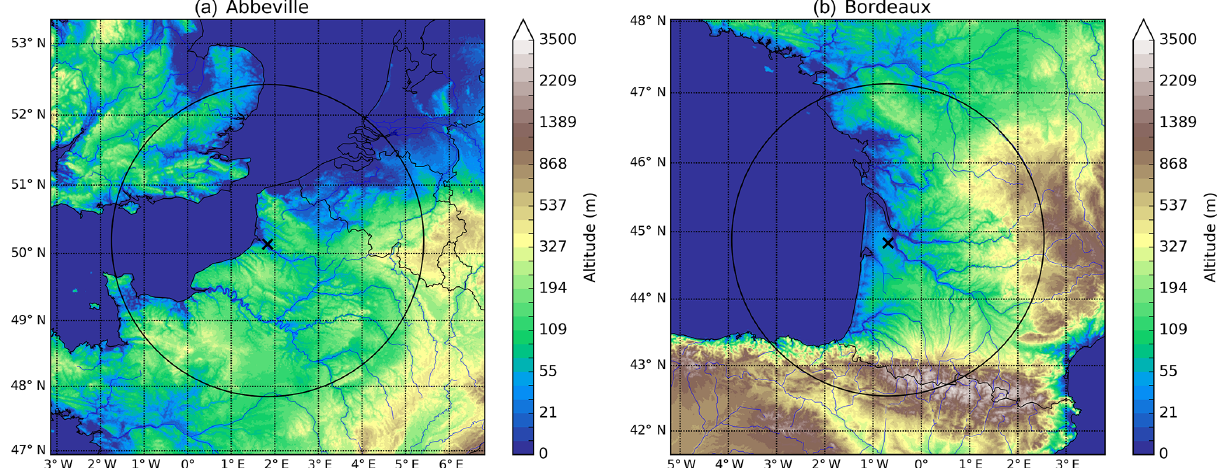
Figure 4. Topography in the Abbeville (a) and Bordeaux (b) radar areas. The radar positions are indicated by the black crosses and their 255km ranges by the black circles. The domain displayed is extended by 100km to represent the NWP model domain used for the compu- tation of the POVPR